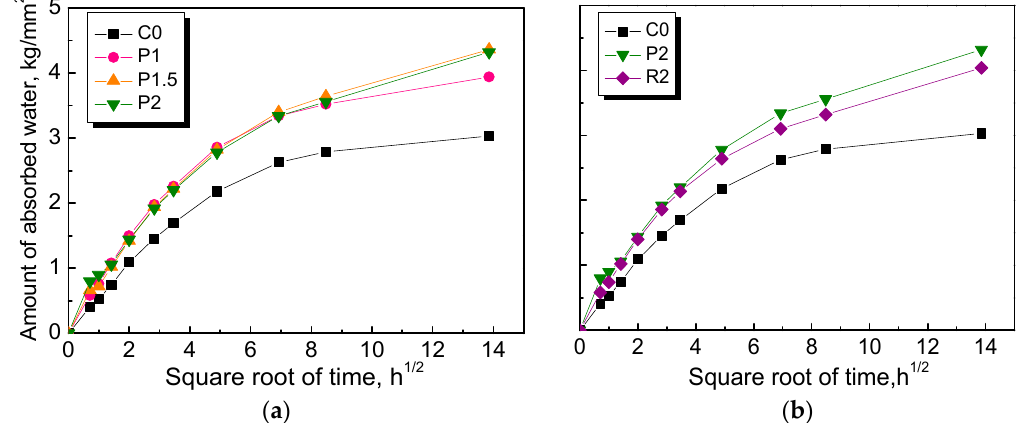
Figure 13. Influence of fiber content ( a ) and fiber type ( b ) on the water capillary absorption of NPFRCCs.